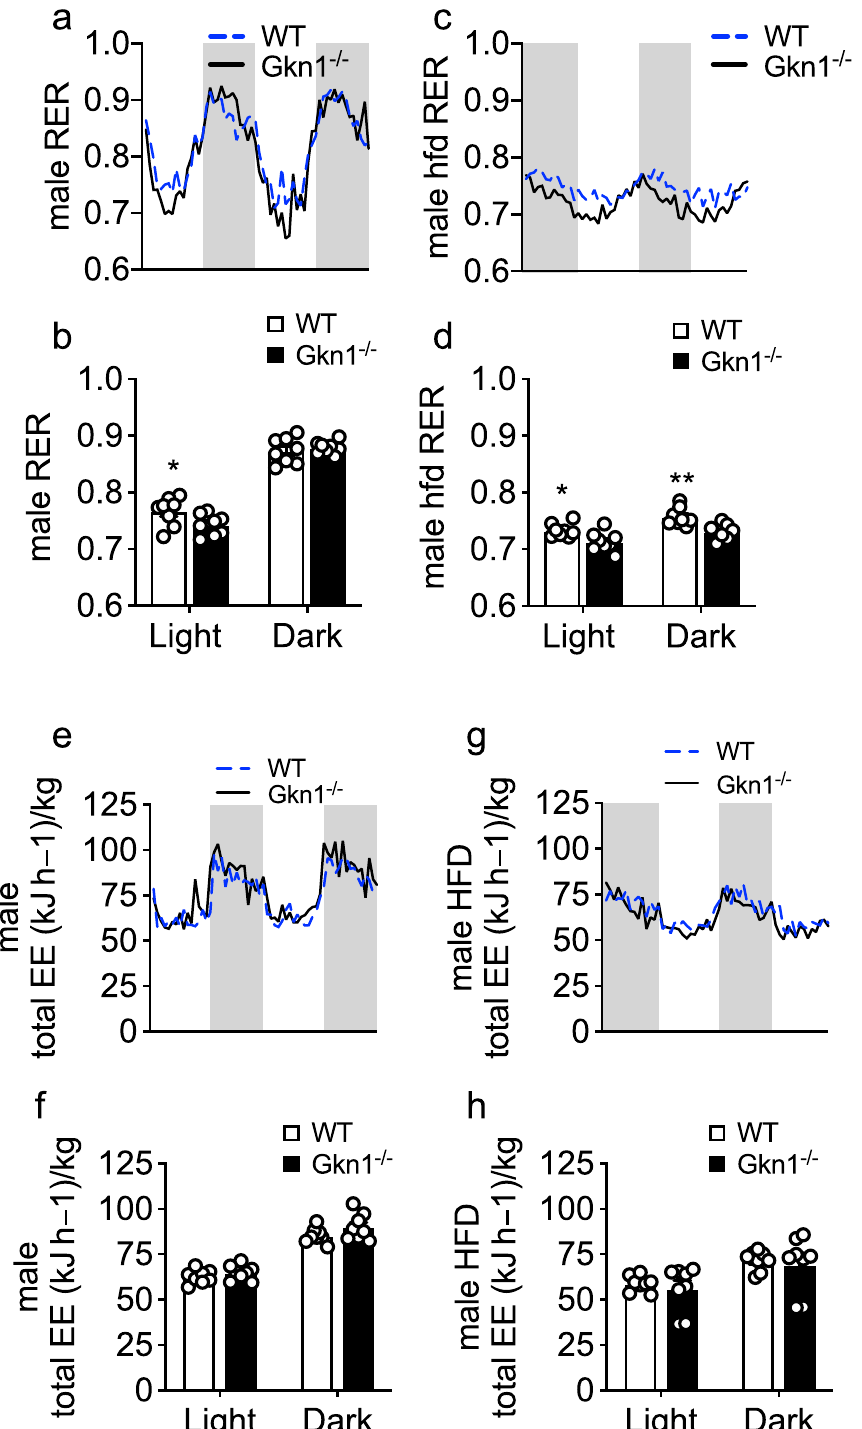
Figure 7. GKN1 regulates metabolism. Male WT and GKN1 −/− mice were individually housed in metabolic cages and monitored for CO 2 production (VCO 2 ) and O 2 consumption (VO 2 ) for 48 h with 12 hr cycles of light and dark and RER was calculated as VCO 2 /VO 2 . ( a ) Mice maintained on NCD show decreased RER during the light cycle (resting period) and increased RER during the dark cycle (active period) with ( b ) a lower average RER in GKN1 −/− mice (black line), compared to WT mice (blue line) during the light cycle. ( c ) Mice maintained on HFD showing a cyclical but blunted pattern of RER with ( d ) a lower average RER in GKN1 −/− mice (black line) compared to WT mice (blue line) during both light and dark cycles. The total body energy expenditure was not significantly different between WT and Gkn1 −/− mice on either the ( e , f ) NCD or the ( g , h ) HFD. In ( a ),( C ),( e ) and ( g ) the lines are the mean of 4 mice with error bars removed for clarity. * p < 0.05, ** p < 0.01 n =